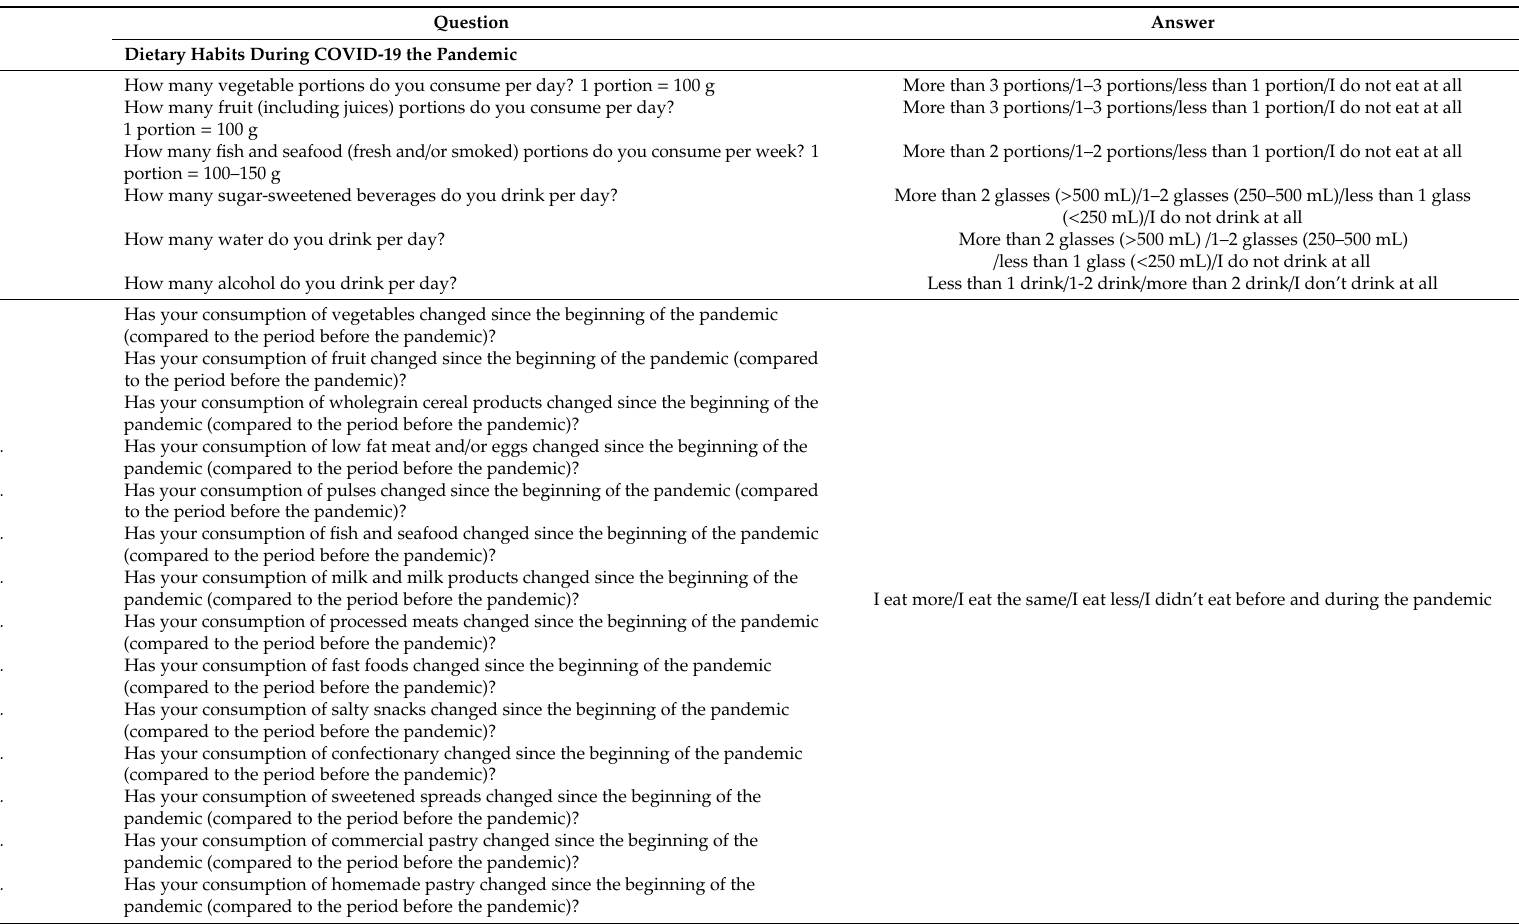
Table A1. Questionnaire PLifeCOVID-19 Impact of COVID-19 the pandemic on the diet and lifestyle of adults (English